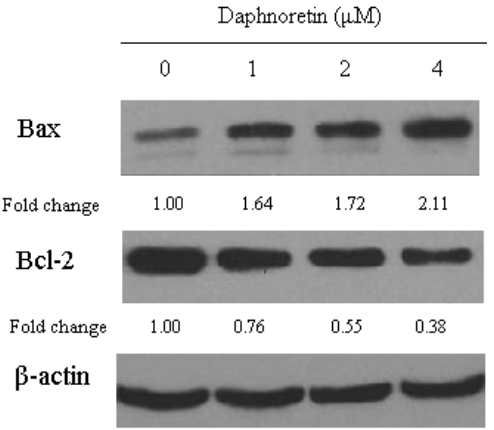
Figure 7. Immunoblotting for the expression of cell cycle-regulating proteins (Bax and Bcl-2) in response to treatment with daphnoretin (0, 1 µM, 2 µM and 4 µM) for 48 h. The blots were stripped and reprobed with anti- β -actin antibody to normalize protein loading. Fold change was calculated as described in Figure 4b.